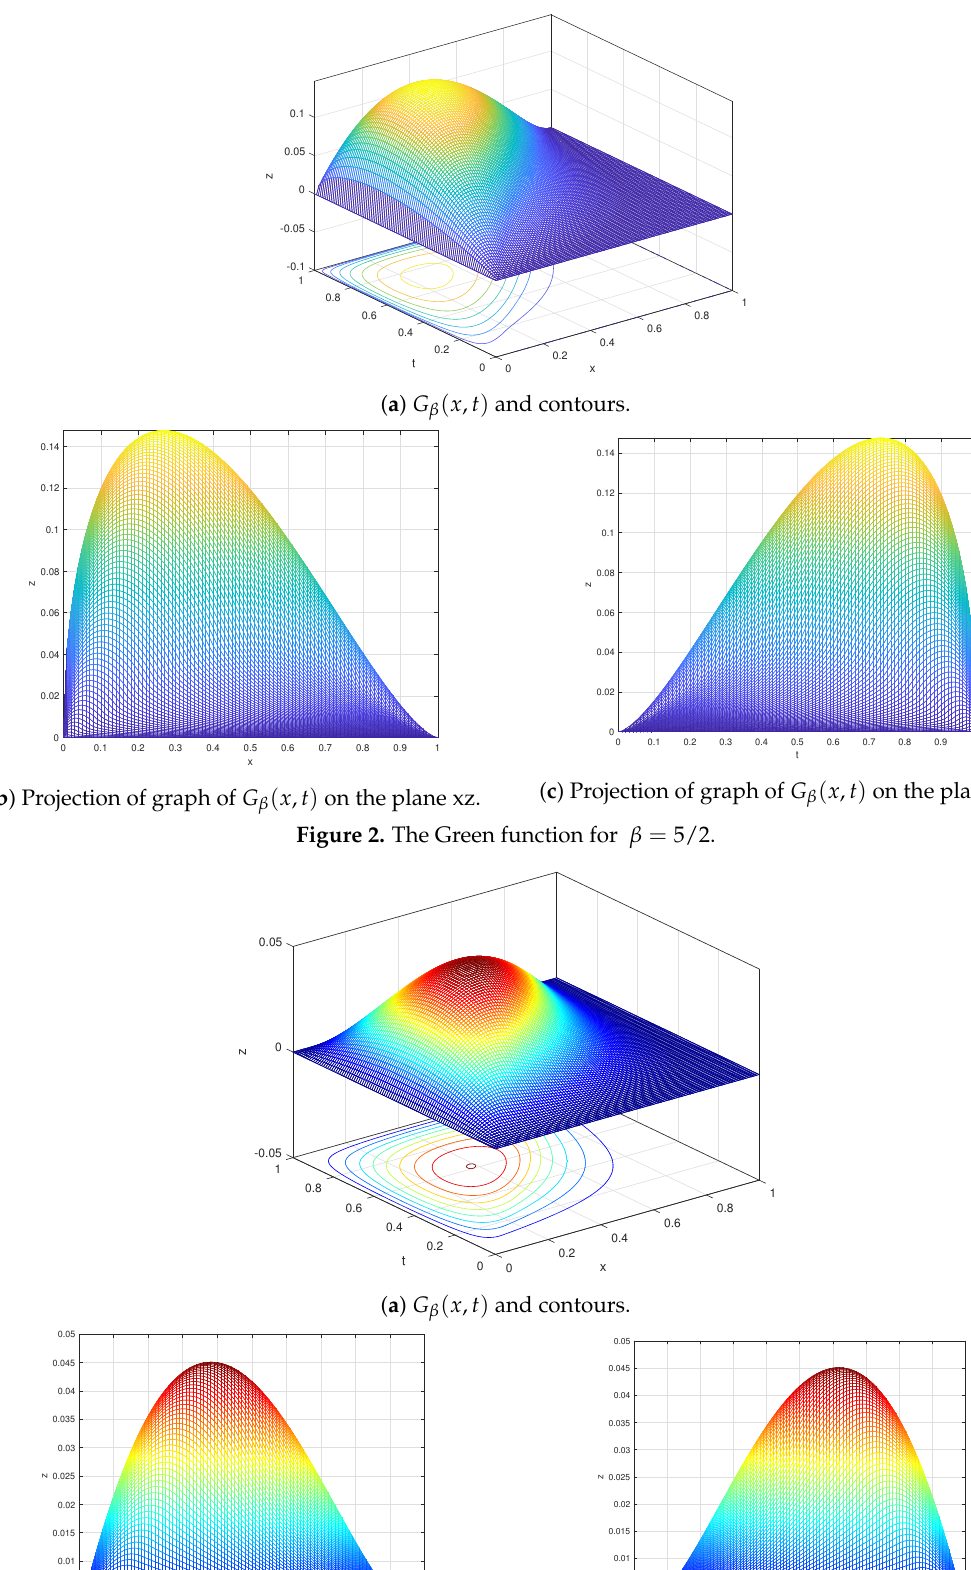
( a ) G β ( x , t ) and contours.